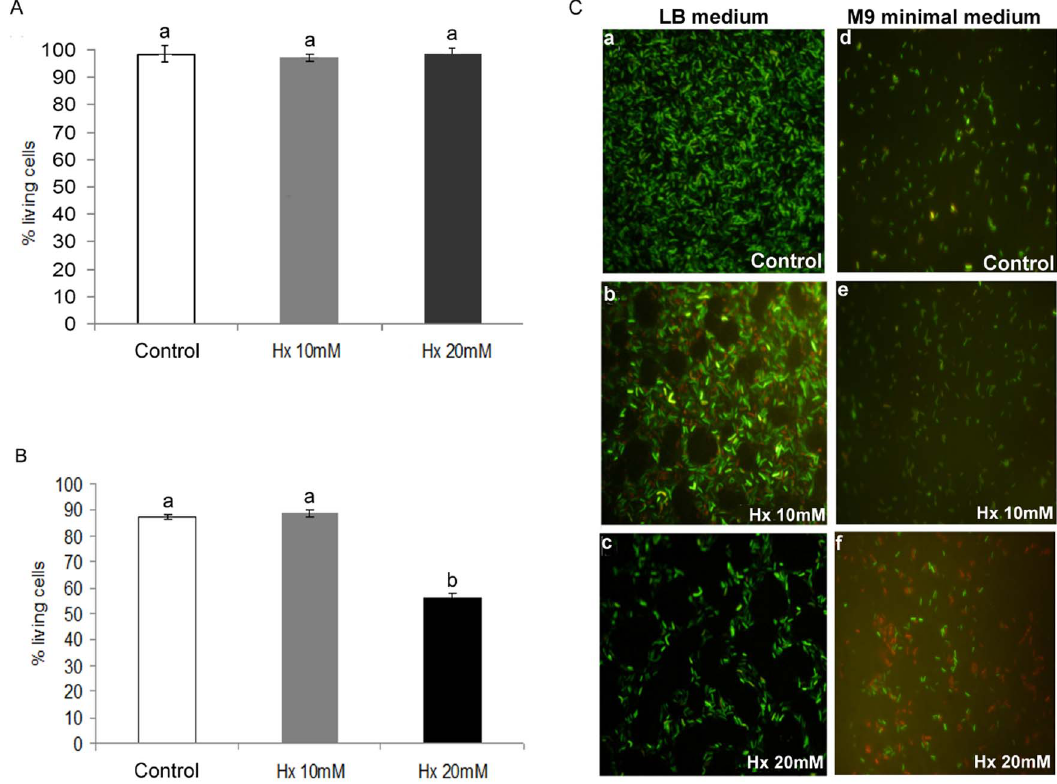
Figure 2. Bactericidal effect of Hx treatment at concentrations of 10 and 20 mM on Pst DC3000. Long-term effect of Hx in LB medium (A). Short-term effect of Hx in minimal medium (B). The charts illustrate the percentage of live cells, which was determined using a Live/Dead Bacterial Viability Kit. The images show the viable (green) and dead (red) cells and illustrated that aggregates are formed after exposure to Hx concentrations of 10 mM and 20 mM only in the long-term experiments (C.2, C.3).